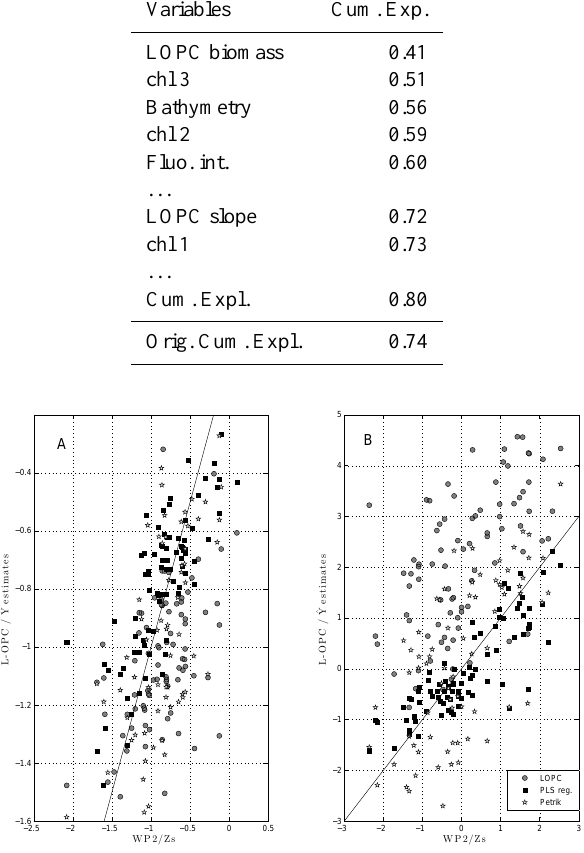
Table 3. Simplified results of the stepwise RDA performed with ad- ditional fractionated chlorophyll a (three fractions) from PELGAS 2009, 2010 and 2011 (68 stations) showing only selected variables; skipped variables are indicated by “...”. Cum. Expl. shows the to- tal cumulated variance explained by the stepwise RDA. Orig. Cum. Expl. shows the total variance explained by the stepwise RDA per- formed on the same subset of stations with the original set of vari- ables (as in Table 2).